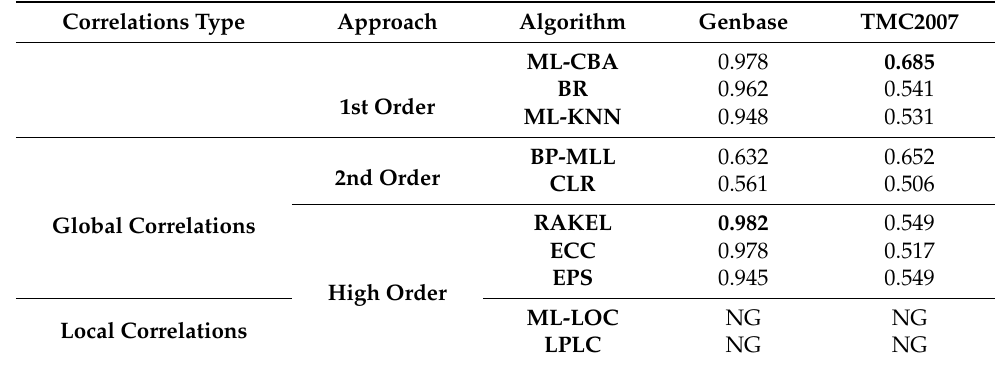
Table 6. The accuracy results of the proposed ML-CBA algorithm on the large-sized datasets, with respect to several other MLC algorithms.